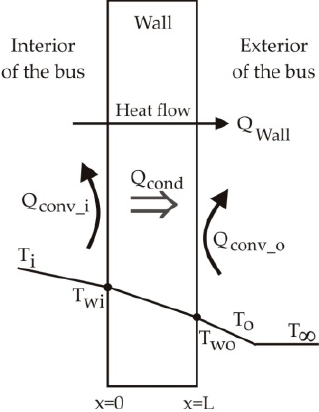
Figure 2. Heat loss through a wall of an electric bus.